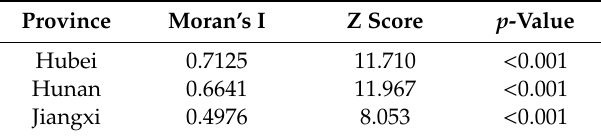
Table 9. Moran’s I values for the Hubei, Hunan and Jiangxi provinces.